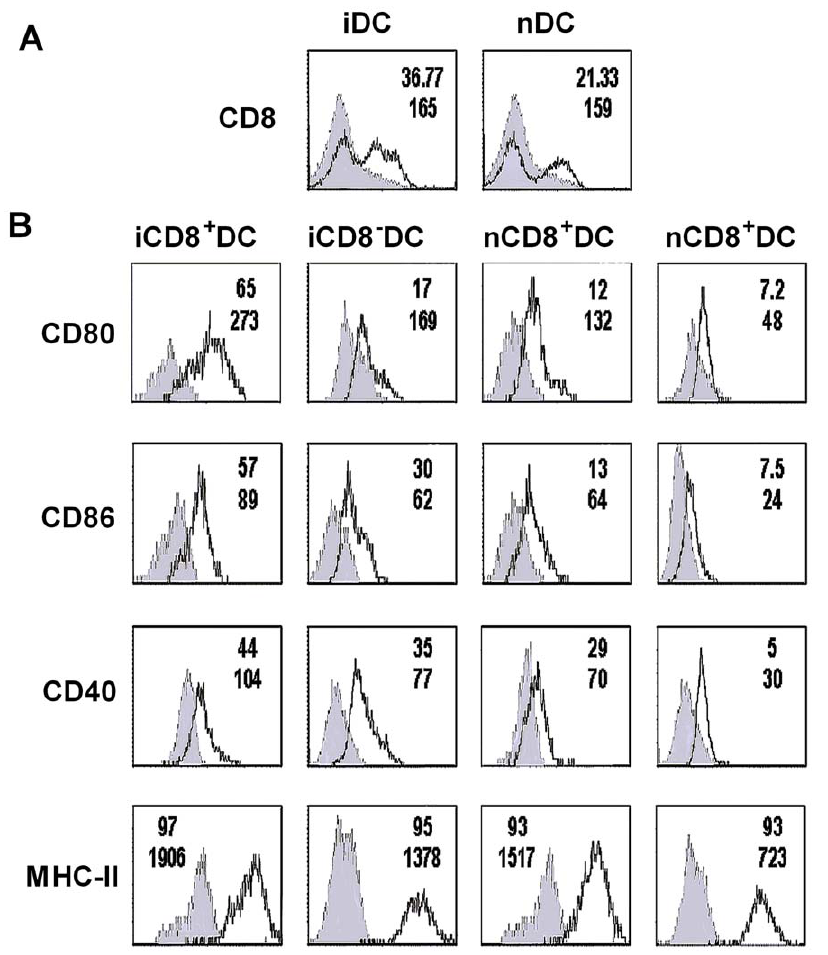
Figure 1. BCG immunization inducedthe expansion of CD8 + DCwhich expressedhigher levels of co-stimulatory moleculescomparedwith CD8 - DC. Mice (C57BL/6, n=4/group) were infected i.v. with 5 6 10 5 CFU of BCG and sacrificed at 21 days after immunization. Total DCs from infected and naı¨ve mice were purified using the MACS CD11c + isolation column. Purified DCs were co-stained with APC-conjugated anti-CD11c, PE-Cy7-conjugated anti- CD8 and FITC-conjugated Ab specific for one of the surface markers (CD80, CD86, CD40 or MHCII). The surface marker expression (solid lines) or matched Ab isotype control (shaded histogram) are shown respectively. All histogram were based on 10,000 cells satisfying a gate set of forward vs side scatter light histogram. A, purified DCs were gated on CD11c positive cells showing CD8 + DC population in infected (iDC) and naı¨ve (nDC) mice. B, purified DC were gated on either CD11c + CD8 + DC (CD8 + DC) or CD11c + CD8 2 DC (CD8 2 DC) and the surface molecules on the DC subsets were shown. The percentages of positive cells andmeanfluorescence intensity(MFI) for themolecules were shownatthe top andbottomlines respectivelyat therightuppercornerof